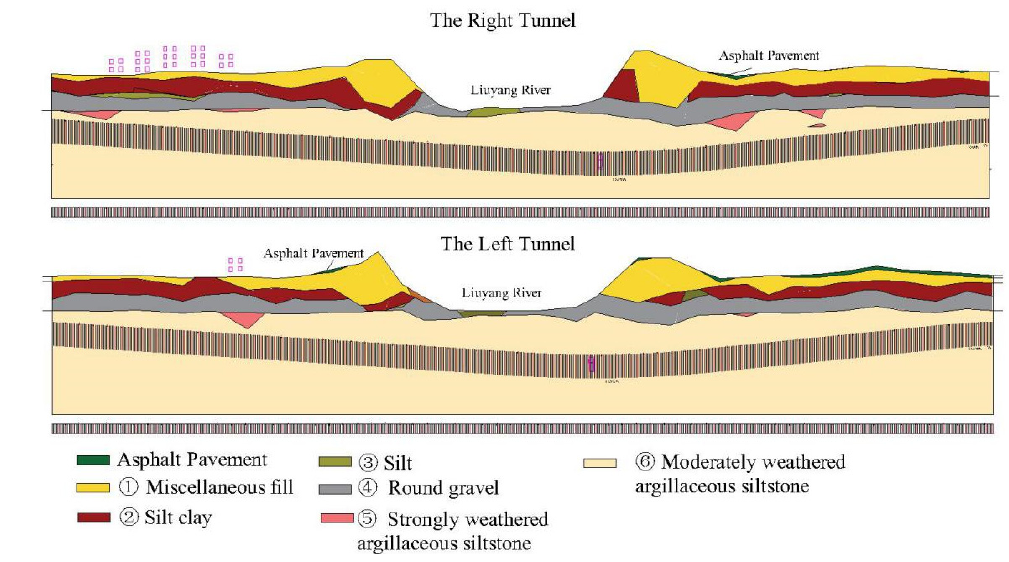
Figure 2. Geological cross-section of the tunnels.